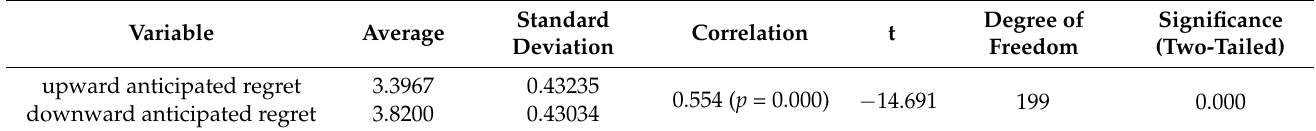
Table 6. The impact of time-limited promotions on anticipated regret.